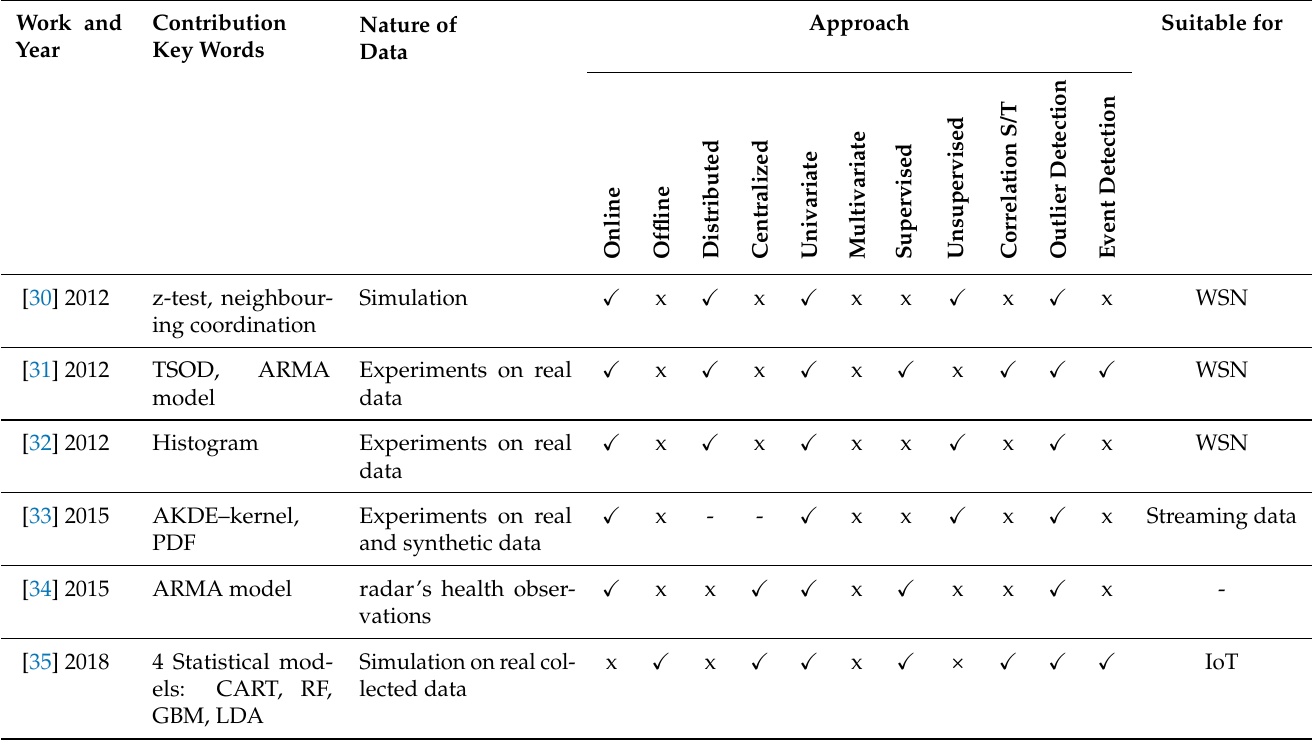
Table 2. Comparative Table of Statistical Based Techniques.